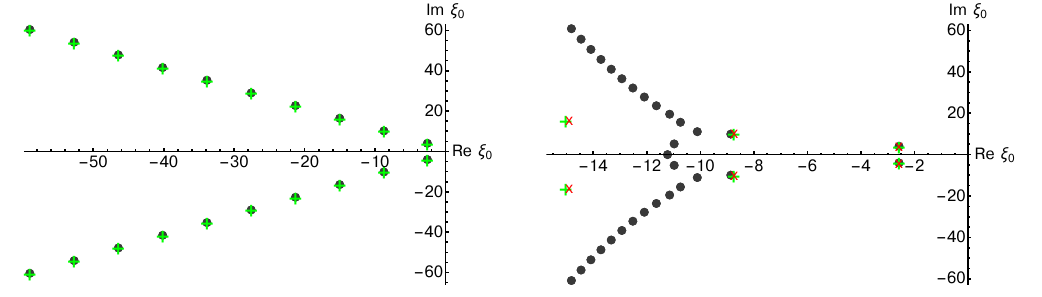
Figure 8 . QNMs and leading singularities on the Borel plane for the ∆ = 2 RG flow with β 2 = 1 (or λ GB = 0) (left panel) and β 2 = 1 . 001 (or λ GB = terms in the expansion (4.12). See text for the